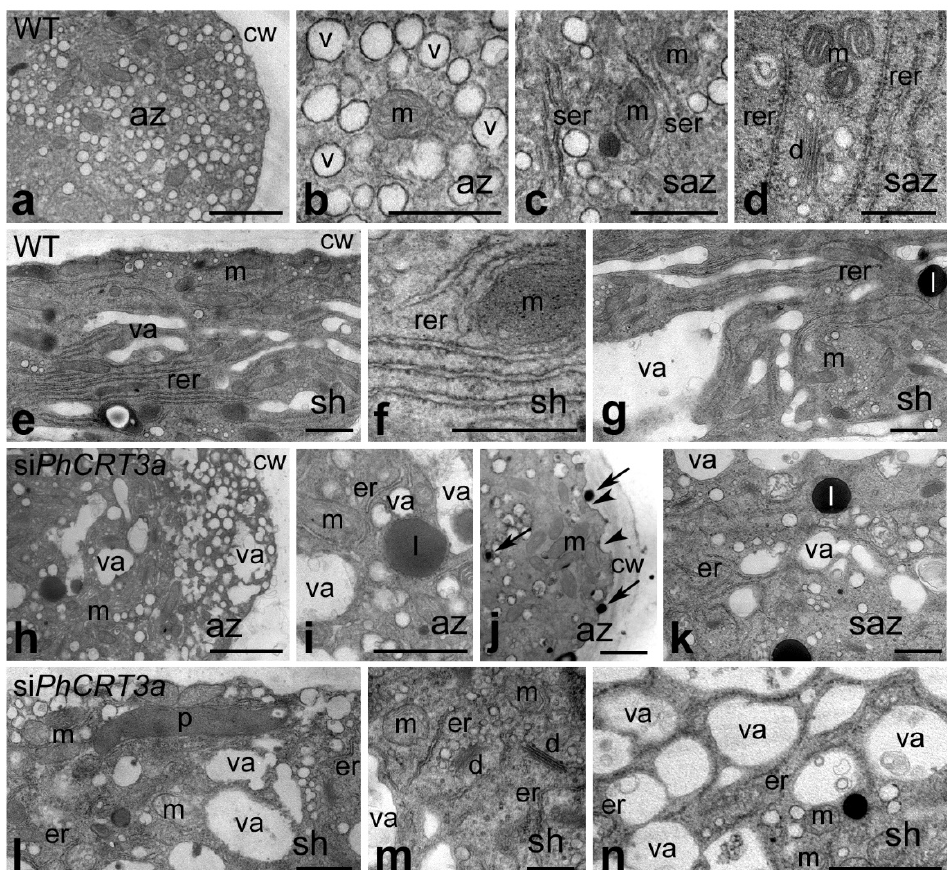
Figure 8. Ultrastructure of WT ( a – g ) and si PhCRT3a -treated ( h – n ) pollen tubes: In WT tubes, the apical zone ( az ; ( a , b )) is packed with vesicles ( v ), and contains a few small organelles, such as mitochondria ( m ); the subapical zone ( saz ; ( c , d )) contains many metabolically active organelles, such as mitochondria, dictyosomes ( d ), and well-developed ER structures ( er ), including rough ER ( rer ) and smooth ER ( ser ). Well-developed ER structures (mainly rer ) are also present in the distal shank ( sh ; ( e , f )), while the proximal shank is highly vacuolated. In si PhCRT3a pollen tubes, the apical zone ( h – j ) contains numerous mitochondria, very short or even fragmentized/disorganized ER, electron-dense vesicles (arrows in ( j )), vacuoles ( va ), plastids ( p ), and lipid bodies ( l ); abnormal callose deposition is observed in the cell wall ( cw ) at the apex (arrowheads in ( j )); in the subapical zone ( k ), only single small organelles, but numerous small vacuoles, are present; the distal shank ( l – m ) is highly vacuolated, and occasionally contains ER; however, numerous vesicles and small organelles such as mitochondria and dictyosomes are localized in this region of the tube; the proximal shank is highly vacuolated ( n ). Bar: 2 µ m ( a , h , n ); 1 µ m ( b – e , g , i – l ); 500 nm ( f , m